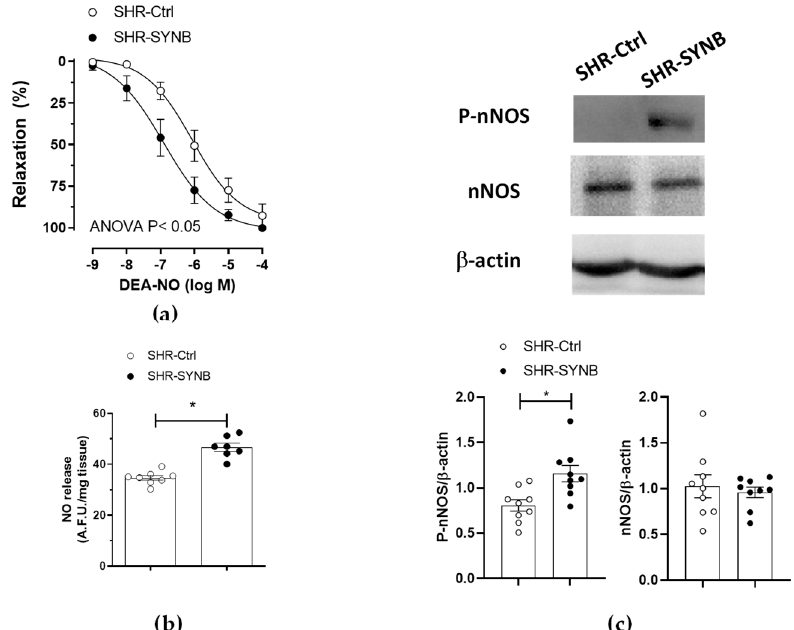
Figure 4. ( a ) Vasodilator response to NO donor DEA-NO in noradrenaline-precontracted mesenteric segments from SHR-Ctrl and SHR-SYNB rats ( n = 6 segments from different animals in each experimental group). Results are expressed as mean ± S.E.M. ( b ) EFS-induced NO release in mesenteric arteries from SHR-Ctrl and SHR-SYNB. Data (Mean ± S.E.M.) are expressed as arbitrary fluorescence units/mg tissue. n = 7–8 segments in each group. * p < 0.05 (Student’s t -test). ( c ) Analysis of nNOS expression and phosphorylation (Ser 1417) in mesenteric rings from SHR-Ctrl and SHR-SYNB. The figure is representative of 9 isolated segments from each group. Lower panel: Densitometry analysis for the expression of each protein. Results (mean + S.E.M.) are expressed as the relation between the signal obtained for the analyzed protein and the signal obtained for β -actin. * p < 0.05 (Student’s t -test).